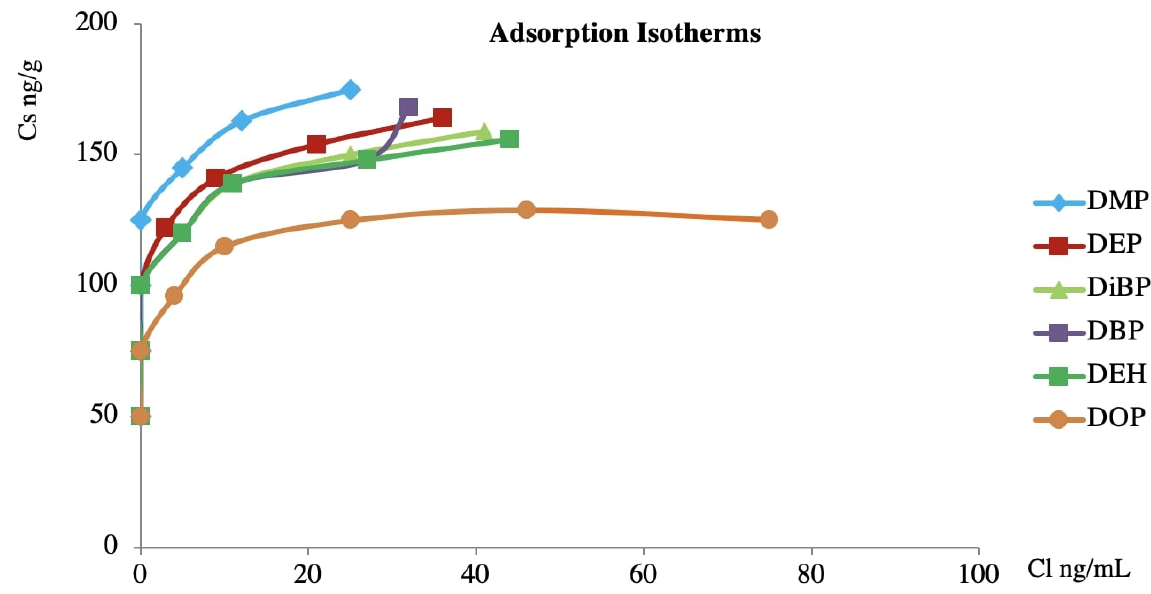
Figure 3. Adsorption isotherm curves at 25 °C of PAEs between the C 18 adsorbent and working solution.